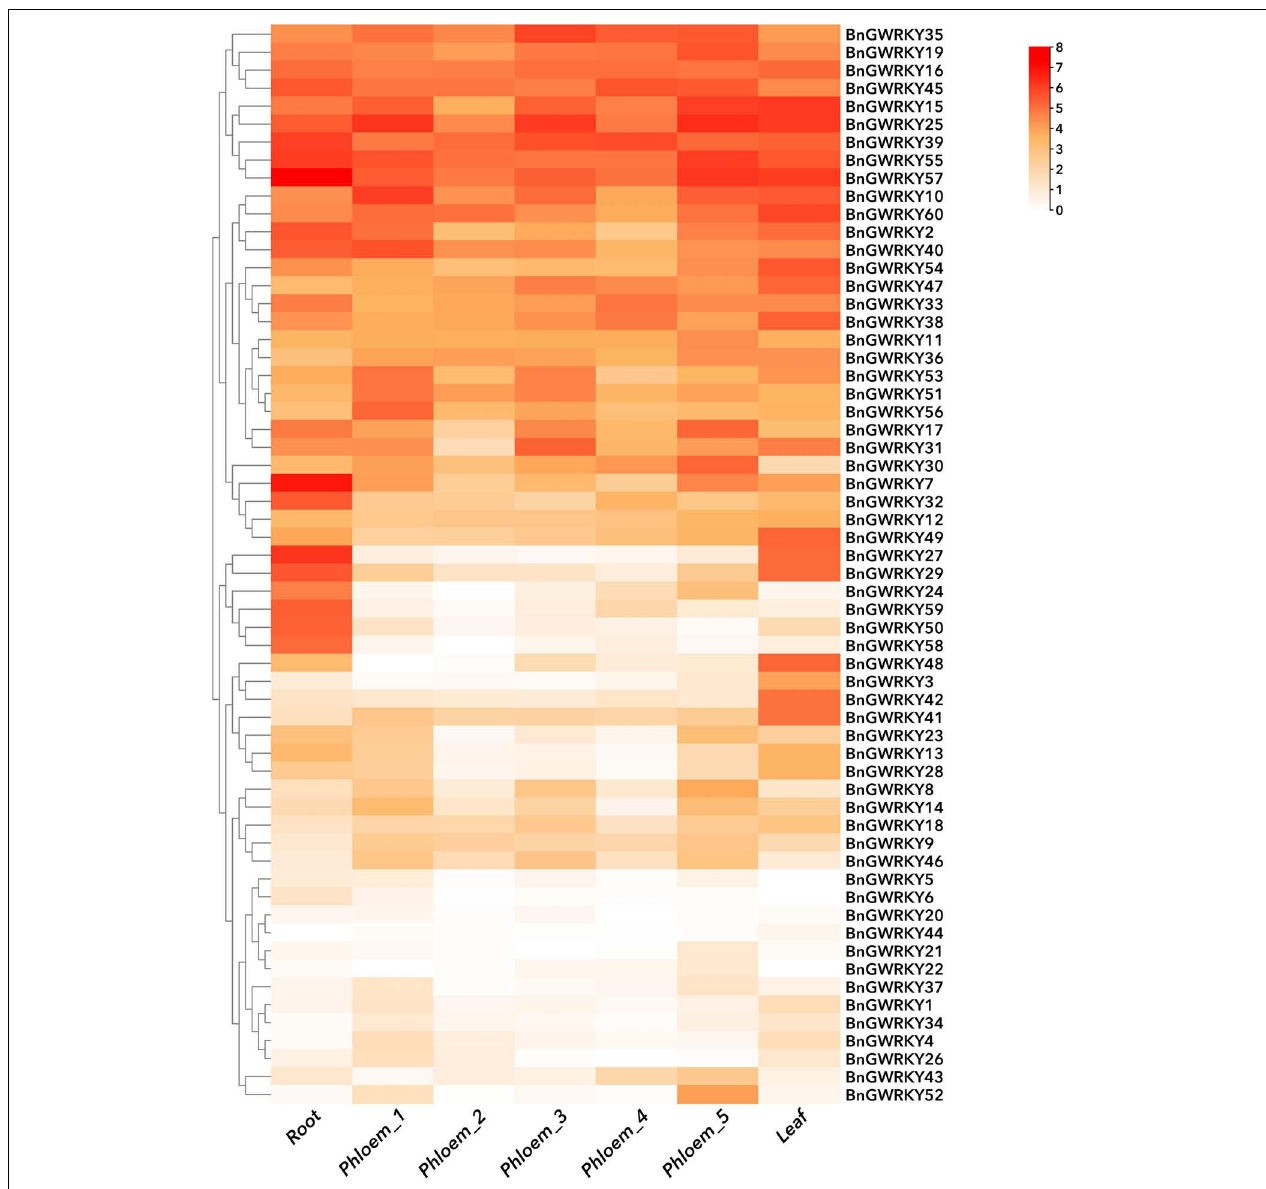
FIGURE 9 | Hierarchical clustering of expression profiles of ramie WRKY genes in nine samples including different tissues and developmental stages. Log2 (FPKM + 1) values were displayed according to the color code. Detailed FPKM values were listed in Supplementary Table 7a .